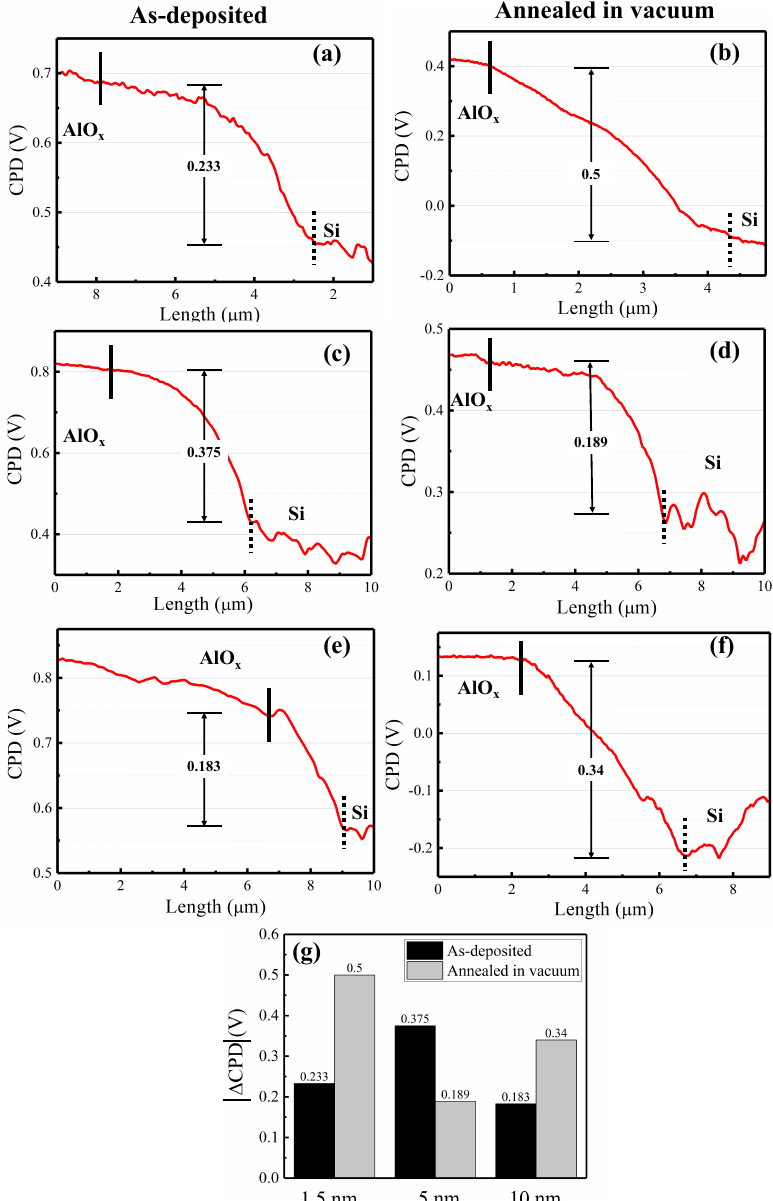
Figure 2. KPFM characterization of six different AlO x passivation samples after annealing in vacuum (right side) as compared to their as-deposited state (left side). ( a , b ) 1.5 nm AlO x . ( c , d ) 5 nm AlO x . ( e , f ) 10 nm AlO x . ( g ) Summary of | ∆ CPD | values for 1.5, 5 and 10 nm AlO x